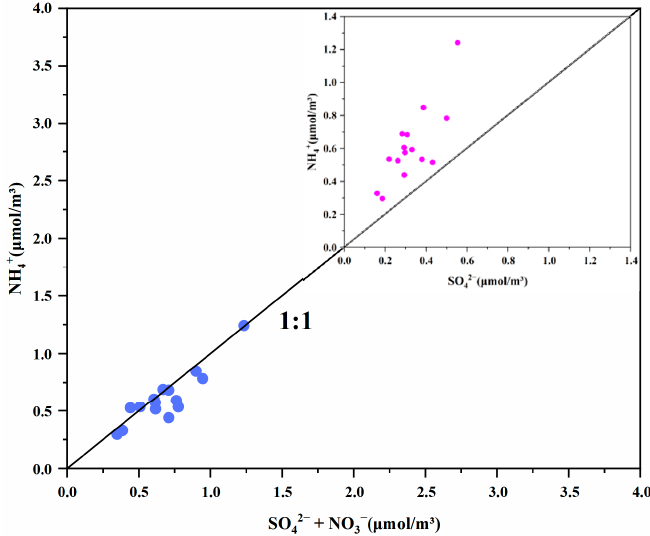
Figure 7. Scatter plot of NH 4+ and SO 42 − +NO 3 − . Figure 8 shows the fitting relationship between the equivalent concentration of three cations and the equivalent concentration of some anions. When the cation was NH 4+ + K + , the scatter points were distributed far below the 1:1 line and were far away from the 1:1 line. The slope of the fitting line was 0.92 and the correlation was strong (R 2 = 0.94). When the cation was NH 4+ + K + + Ca 2+ , most of the scatter points were distributed above the 1:1 line and the slope of the fitted line was 0.91, but the correlation coefficient (R 2 = 0.65) was smaller. When the cation was NH 4+ + K + + Mg 2+ , the slope of the fitted straight line of the equivalent concentration of the three anions and the three cations was closest to 1:1 (R 2 = 0.96), showing that the equivalent of the anions and the cations was almost balanced. Therefore, the combination of anions and cations was likely to result in NH 4+ being able to neutralise most of SO 42 − and NO 3 − to form (NH 4 ) 2 SO 4 and NH 4 NO 3 , while K + and Mg 2+ existed in the form of KCl and MgCl 2 .